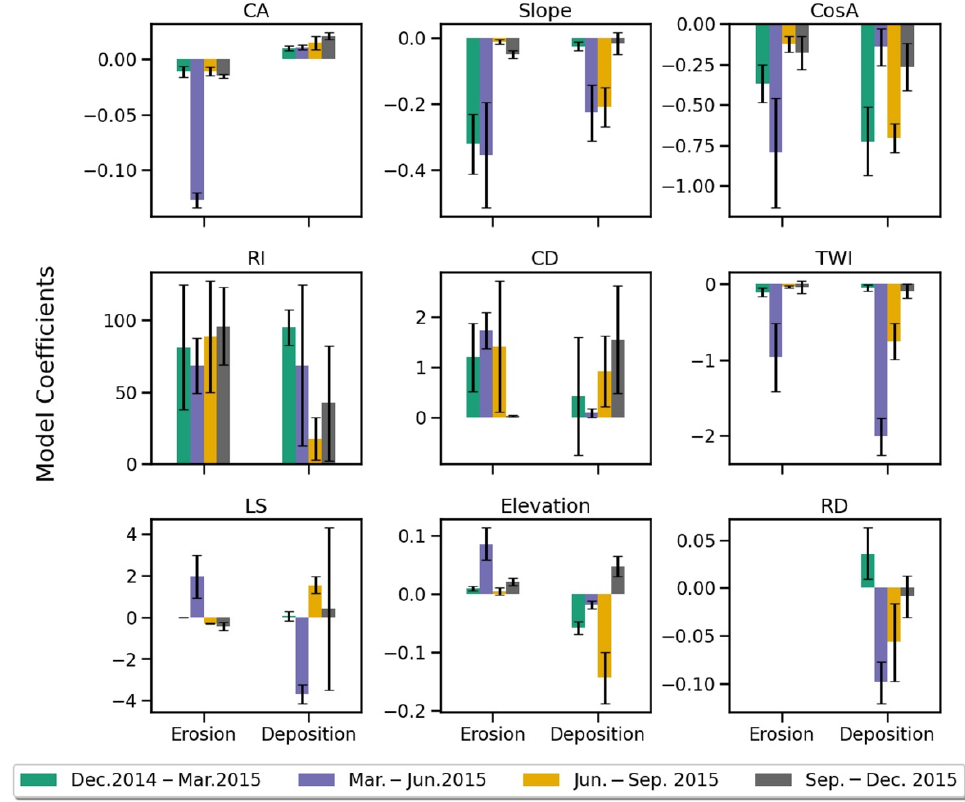
Figure 5. Coefficient of each topographic factor summarized for cross-seasonal comparisons. Note that RD is not included in the final erosion model.